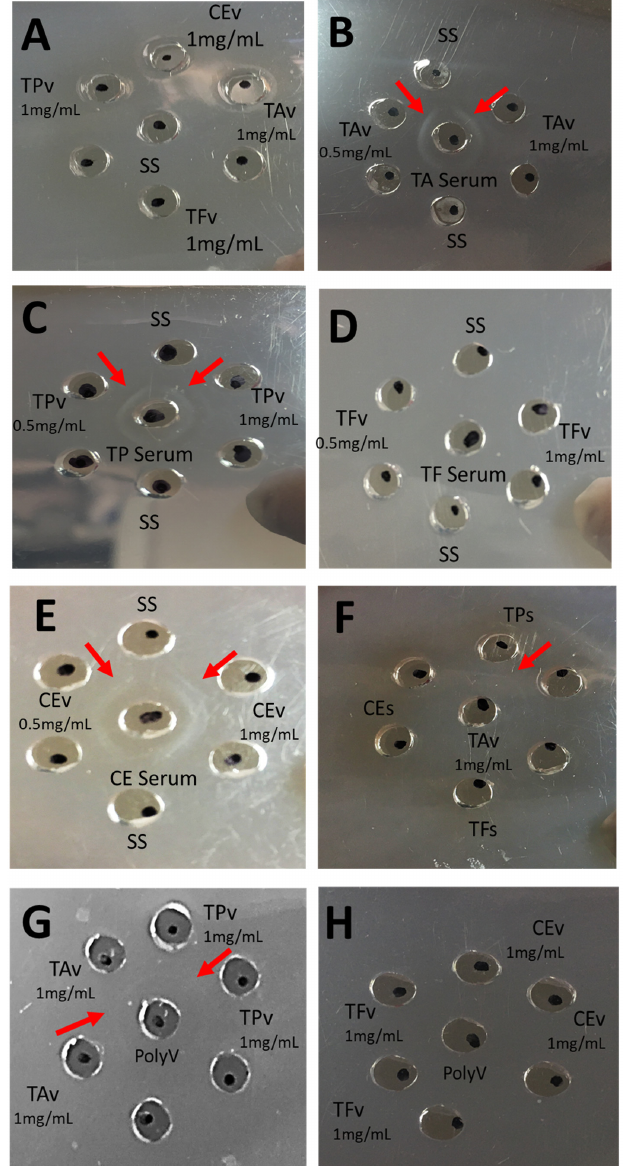
Figure 5. Double immunodiffusion assay. Antigen/antibody recognition assay of antigen batches (0.5 mg/mL and 1 mg/mL) against hyperimmune serums. ( A ) Negative Control using 0.9% saline physiological solution (S.S.); ( B ) Tityus asthenes ; ( C ) Tityus pachyururs ; ( D ) Tityus fuhrmanni ; ( E ) Cen- truroides spp. ( F ) recognition of Tityus asthenes venom by different hyperimmune serums. ( G , H ) Recog- nition of pooled hyperimmune serum (PolyV) with different venoms (1 mg/mL). Arrows indicate venom and hyperimmune recognition. Red arrows indicate recognition